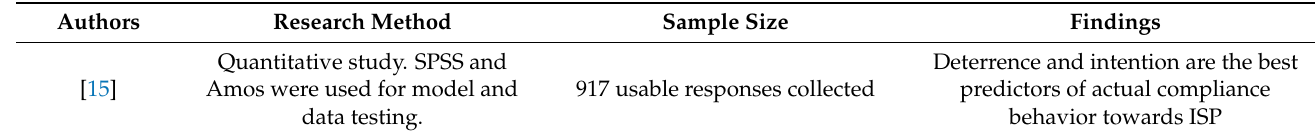
Table 10. Studies on actual compliance